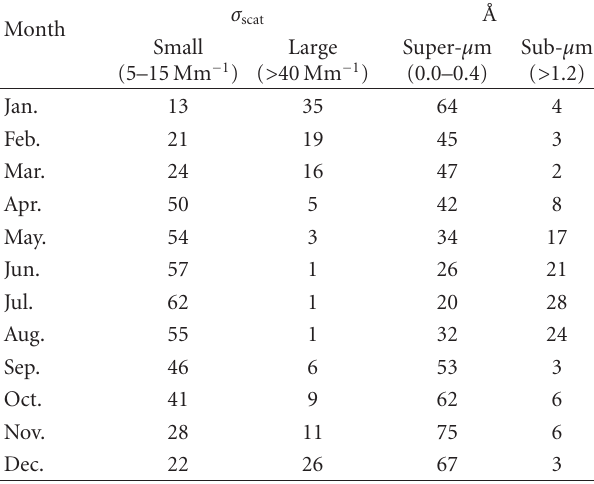
15 Mm − 1 ) and larger ˚A values ( > 1.2) are higher for